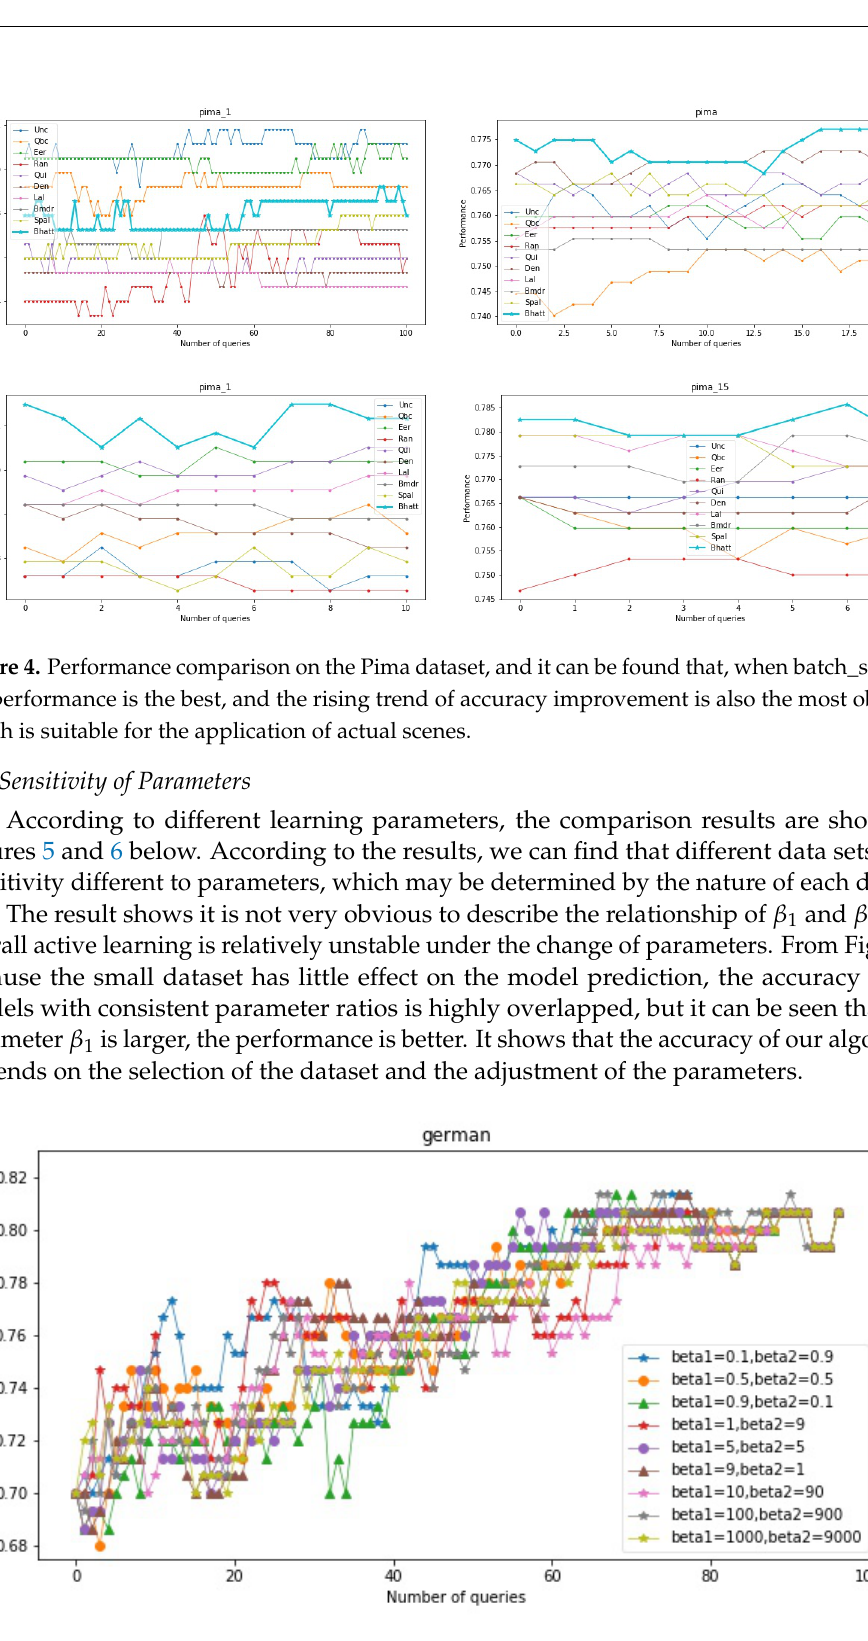
Figure 5. Performance comparison about different parameters on German